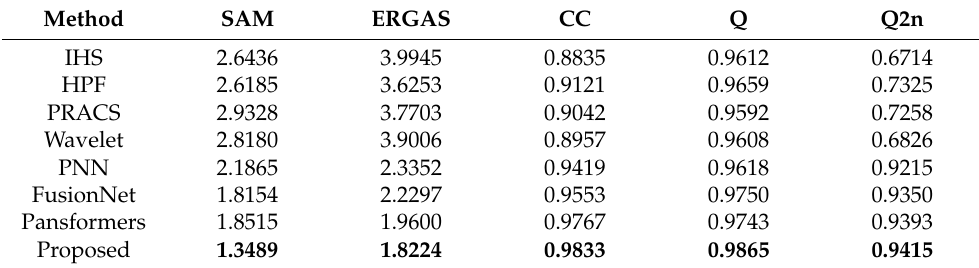
Figure 9. Simulation experiment results using the GaoFen-2 dataset. ( a ) IHS, ( b ) HPF, ( c ) PRACS, ( d ) Wavelet, ( e ) PNN, ( f ) FusionNet, ( g ) Pansformers, ( h ) LNFIN, ( i ) GT. Table 5. Quantitative evaluation of simulation experiment results using the GaoFen-2 dataset.